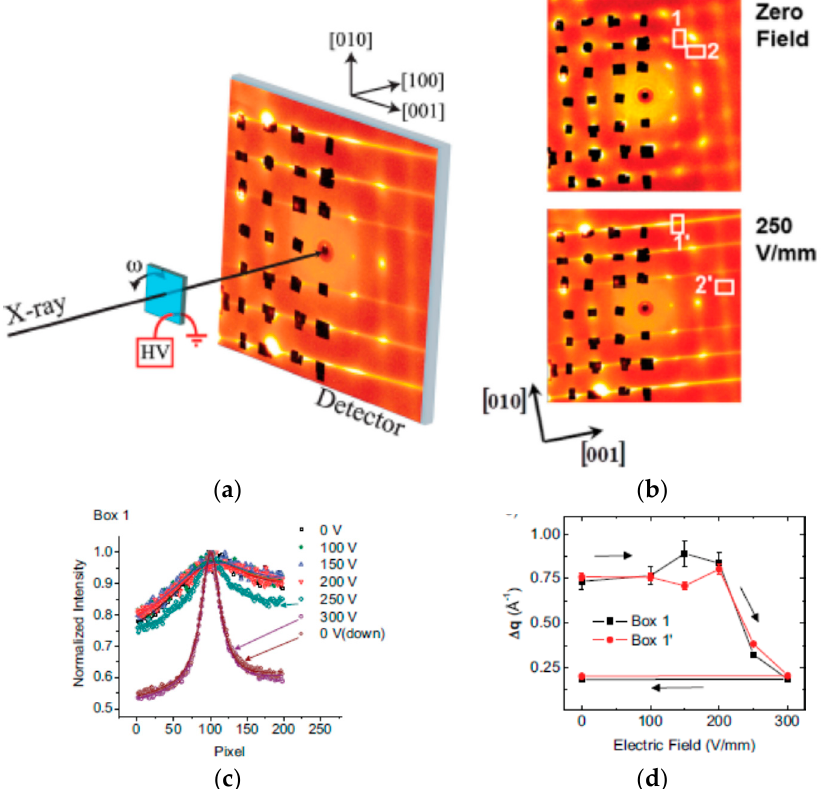
Figure 6. ( a ) Schematic illustration of an experimental set-up for an in situ measurement of single-crystal diffuse scattering pattern under applied electric fields using high-energy X-rays and a 2-dimensional area detector. In order to enhance the contrast for the diffuse scattering pattern, the Bragg diffraction spots are blocked with Pb tapes (shown in black). ( b ) Electric-field-induced change in diffuse scattering pattern. Quantitative characterization of length scale of atomic displacements correlations along different directions can be obtained based on integrated line profiles near different zone centers (ZC), marked by white boxes. ( c ) The integrated line profiles as function of applied electric fields, for box 1 near 022 ZC. ( d ) The full width at half maximum (FWHM) of the line profiles, plotted as ∆ q , is inversely proportional to the correlation length of the off-center B atom displacements. After Pramanick et al. [57] Reprinted from reference [57], with permission from John Wiley and Sons.